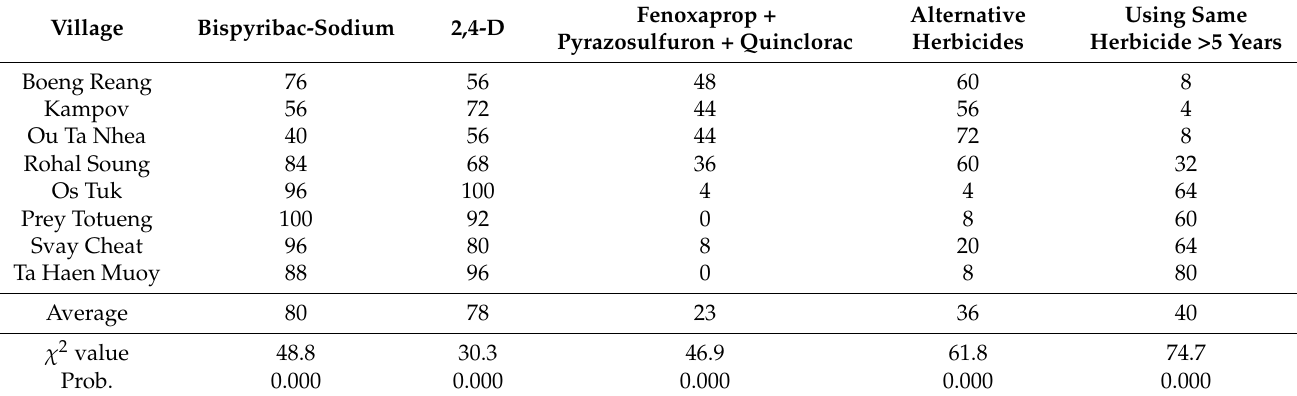
Table 6. Variation in herbicide use between villages: % of households using a particular herbicide. Village